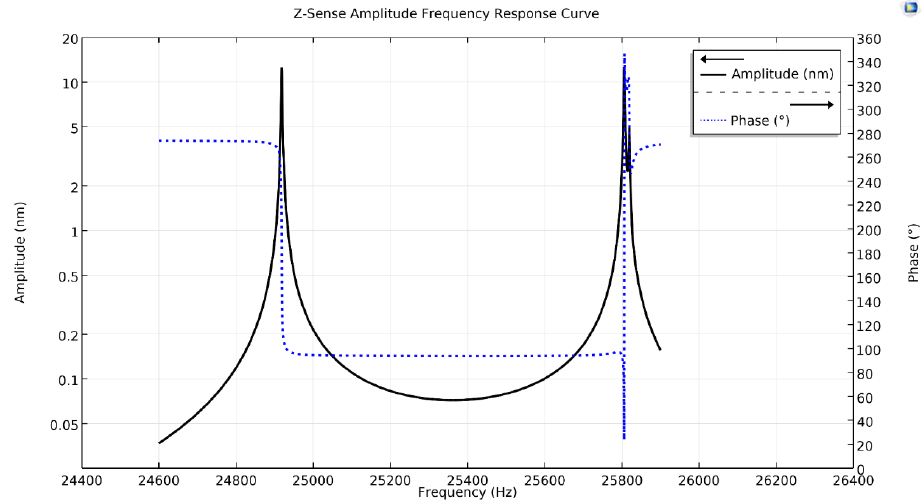
Figure 7. Z-sense amplitude frequency response curve of the proposed single-drive, 3-axis MEMS gyroscope. Table 5. Analytical and FEA simulated sense-displacements comparison.